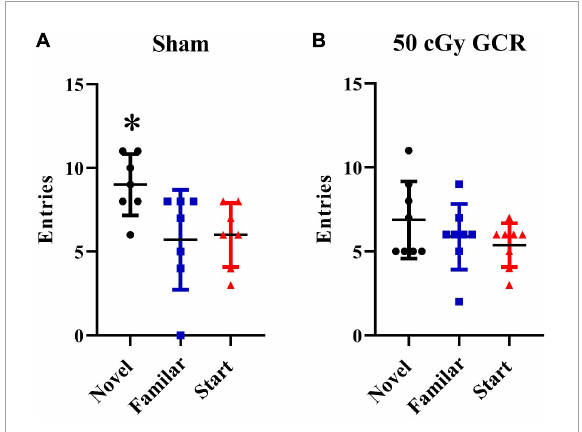
FIGURE1 Y maze. (A) Sham-irradiated mice ( n = 6) had significantly more entries into the novel arm during the testing phase of the Y maze, indicating normal spatial recognition. (B) Irradiated mice ( n = 6) (50 cGy GCR) were unable to distinguish between the 3 Y-maze arms, indicating that GCR exposure impaired short-term memory. * P < 0.05.